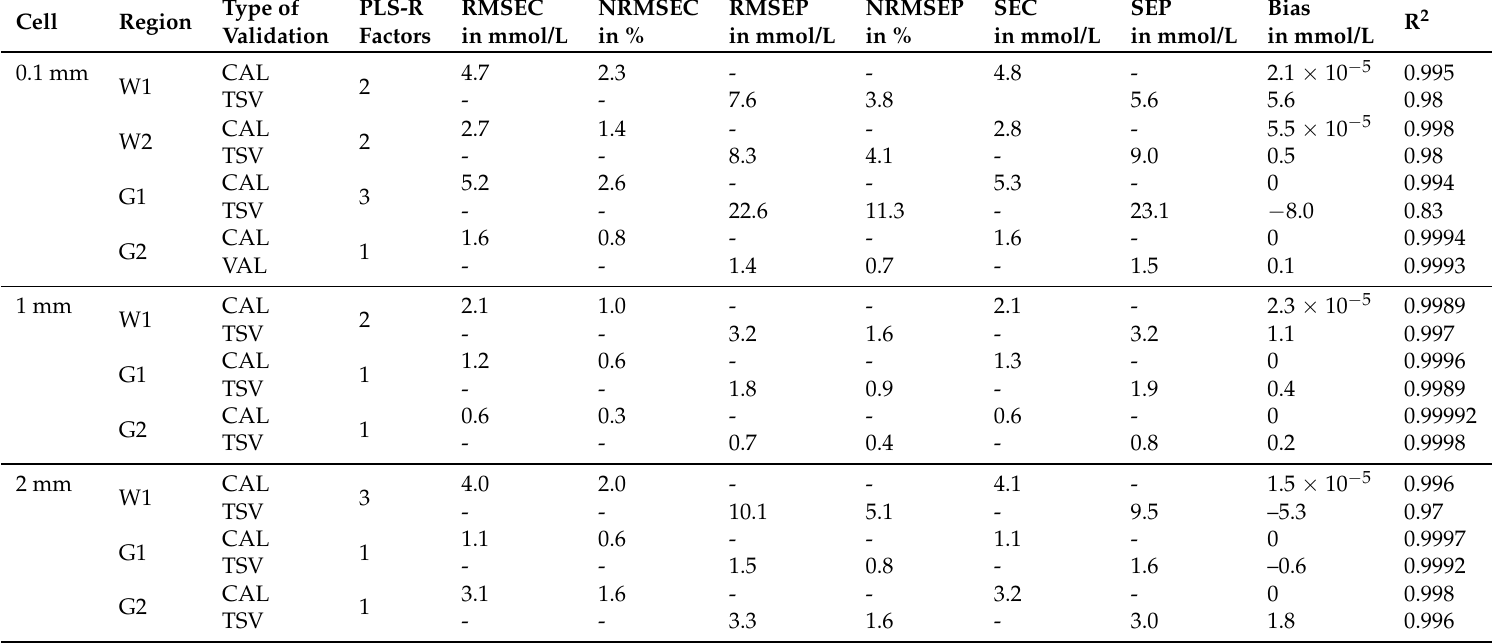
Table 2. Results of the PLS-R calibration and test set validation for all three cell pathlengths as well as for each spectral